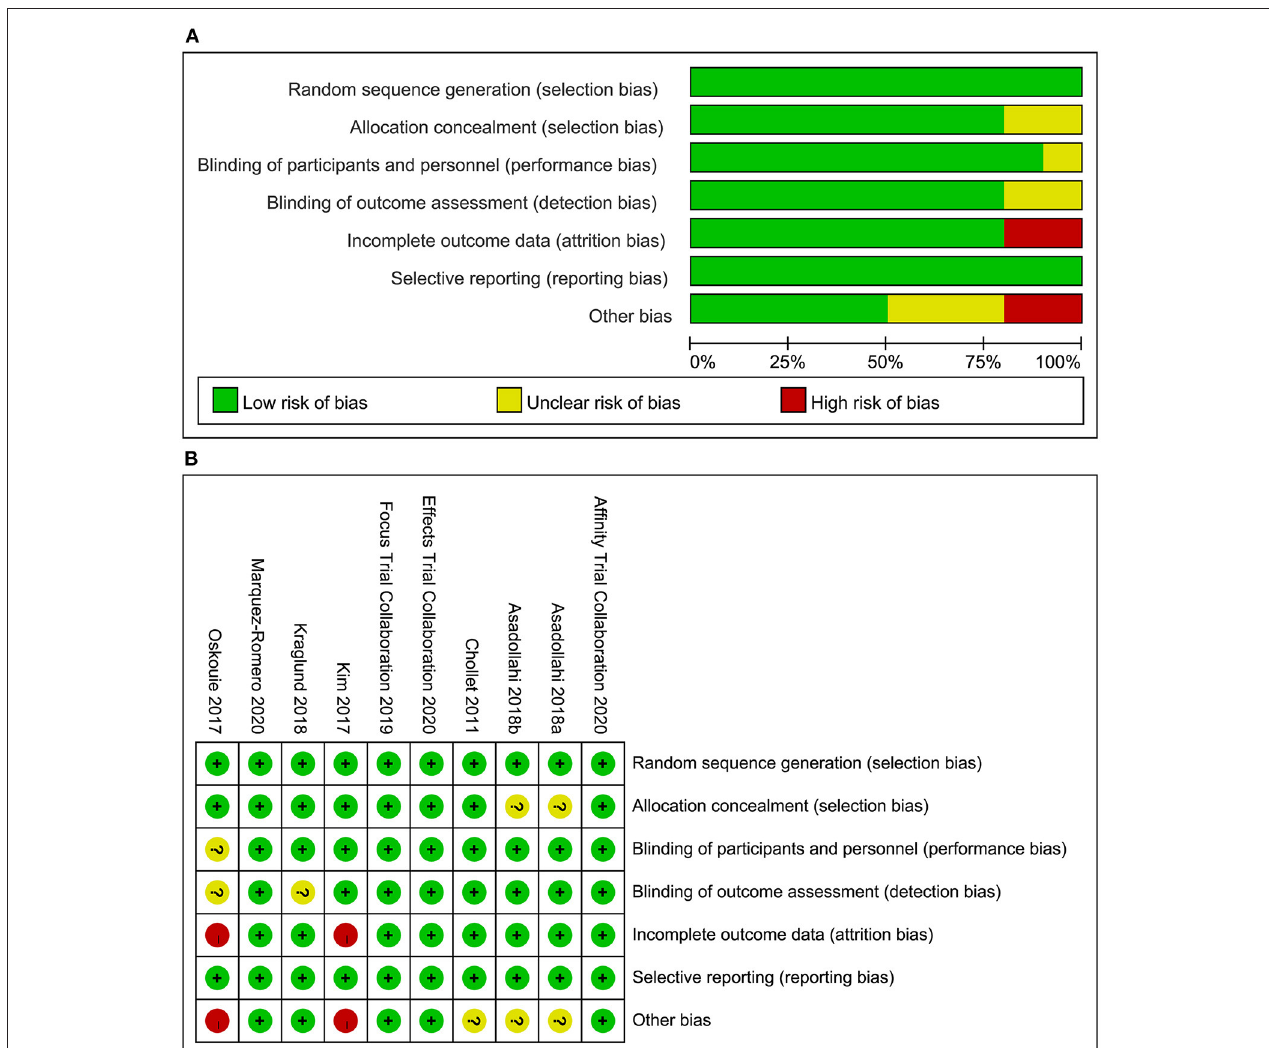
FIGURE 2 | (A) Risk of bias graph: review authors’ judgements about each risk of bias item presented as percentages across all included studies, (B) Risk of bias summary: review authors’ judgements about each risk of bias item for each included study.